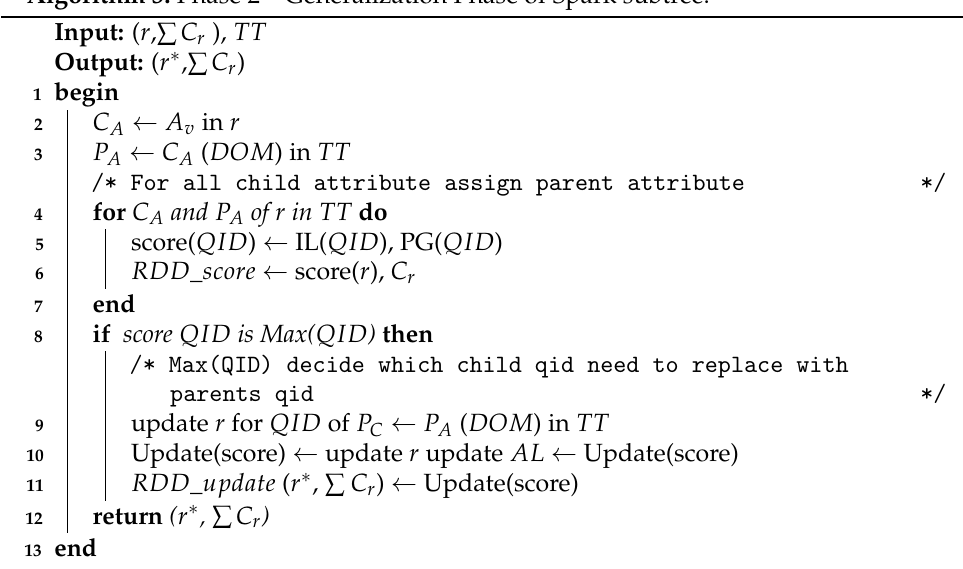
Algorithm 3: Phase 2—Generalization Phase of Spark